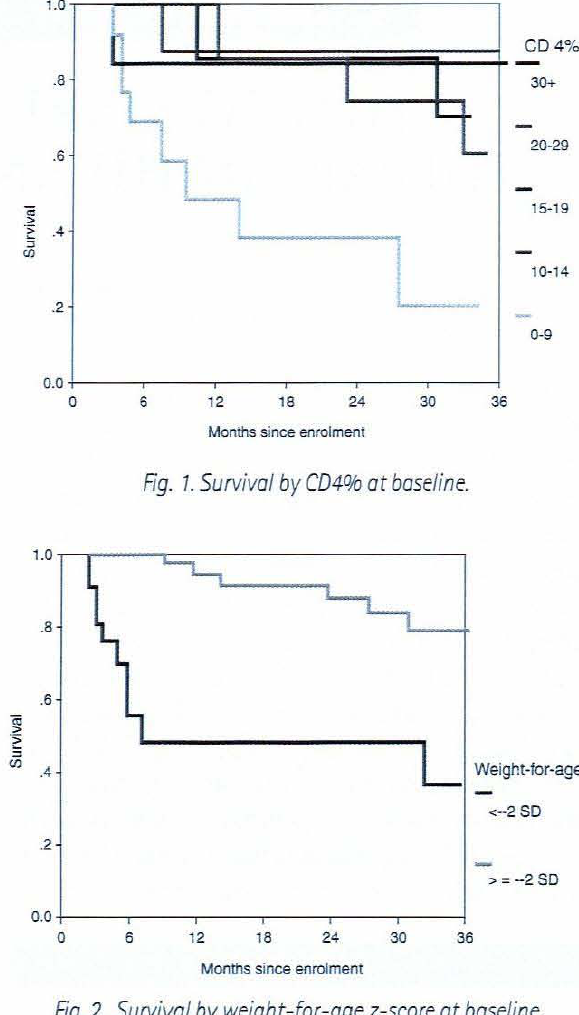
Fig. 2. Survival by weight-for-age z-score at clinically and have annual tests for virological and immunological deterioration. Survival to 3 years by Kaplan Meier methods was significantly associated with higher CD4% and higher weight-for-age at enrolment (Figs 1and 2)." Children with CD4% < 10% had the worst outcomes, with no significant difference between the groups at higher levels. Those with weight-for-age z-scores less than -2 SD also had a significantly poorer outcome than the others. Viral load at baseline was not auseful predictor of outcome over the 3 years. Clinical status at enrolment predicted